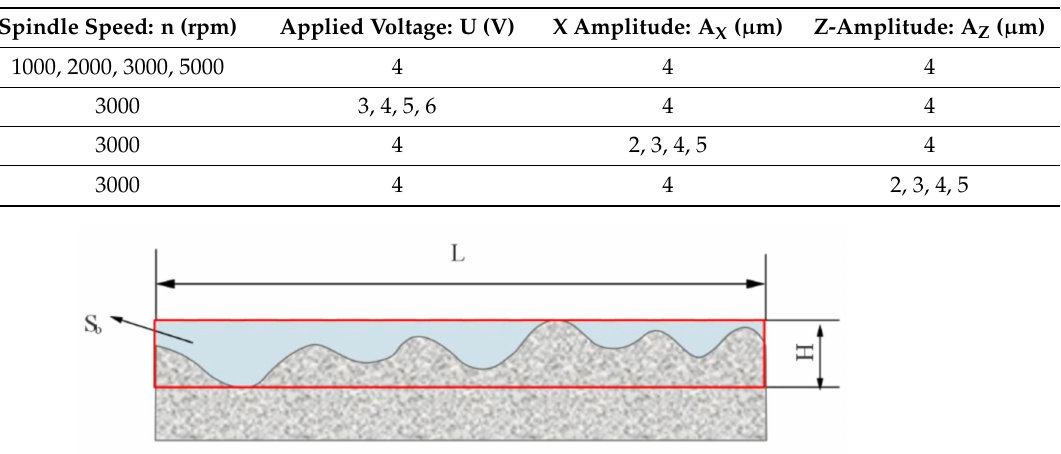
Table 3. Machining parameters for 2UE/DM.